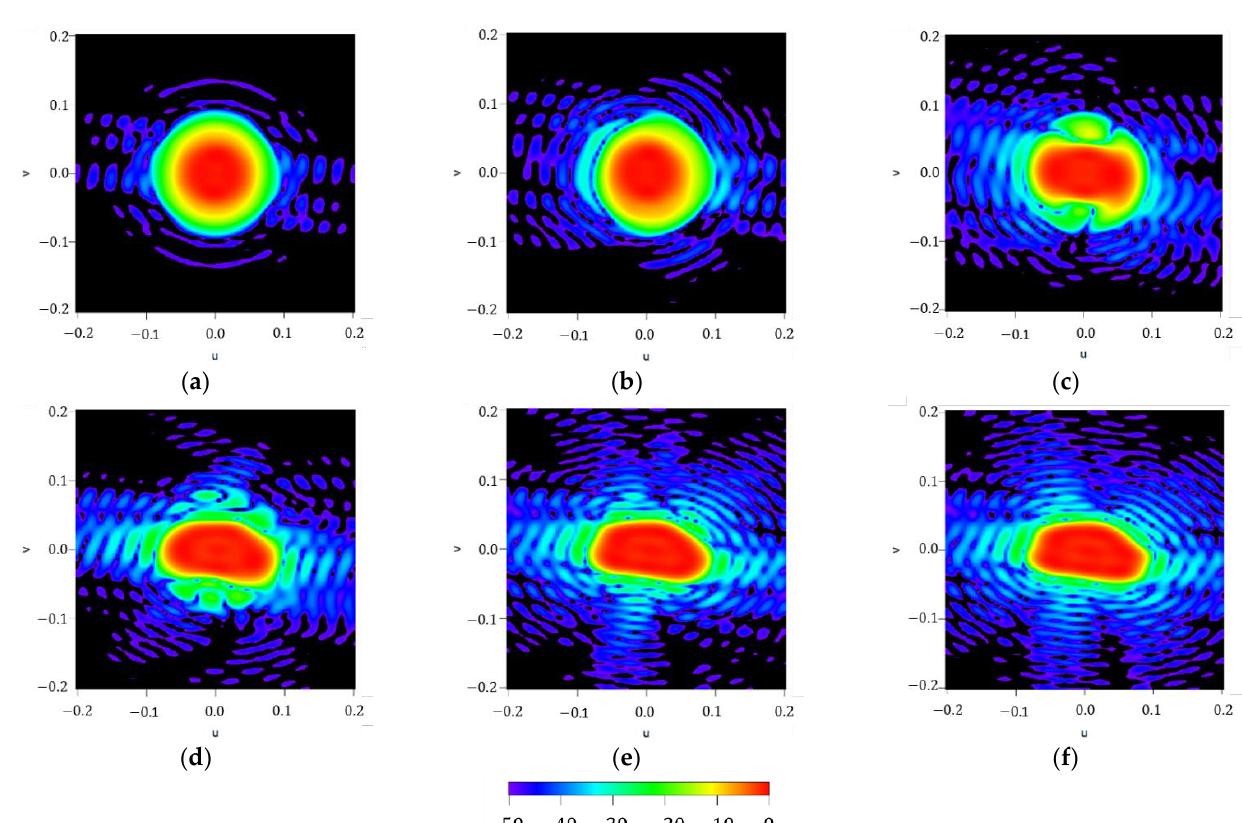
Figure 14. Figure series illustrating the iterative process devoted to generating a rectangular footprint by increasing the maximum order of the aperture distribution series described in (7): ( a ) N K max = 0, ( b ) N K max = 1, ( c ) N K max = 2, ( d ) N K max = 5, ( e ) N K max = 10, and ( f ) N K max = 28. All the interpolated plots here described have a threshold level set at − 50 dB for the normalized far-field power.